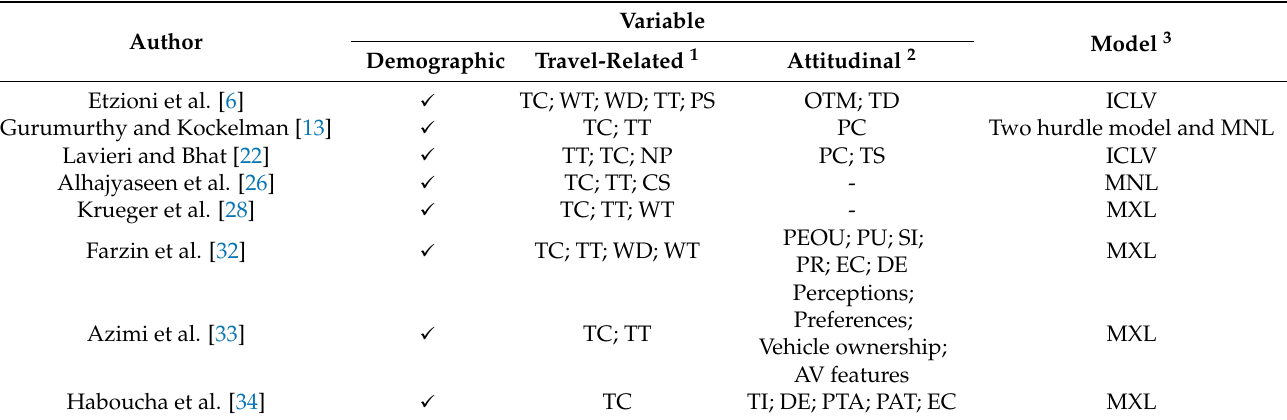
Table 1. A brief review of previous studies in choosing different types of AVs.